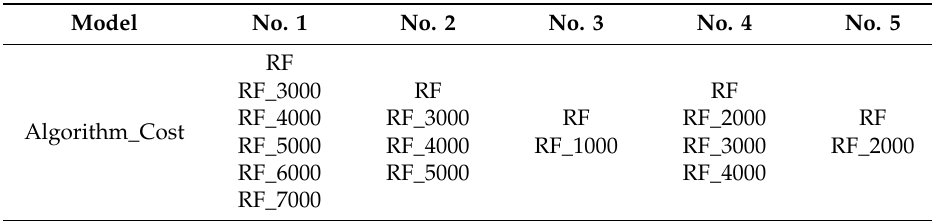
Table 3. The representative models using the random forests (RF) algorithm with the costs for verifications based on pervious comparisons. For example, RF_3000 indicates that the RF algorithm with a cost of 3000 was used.